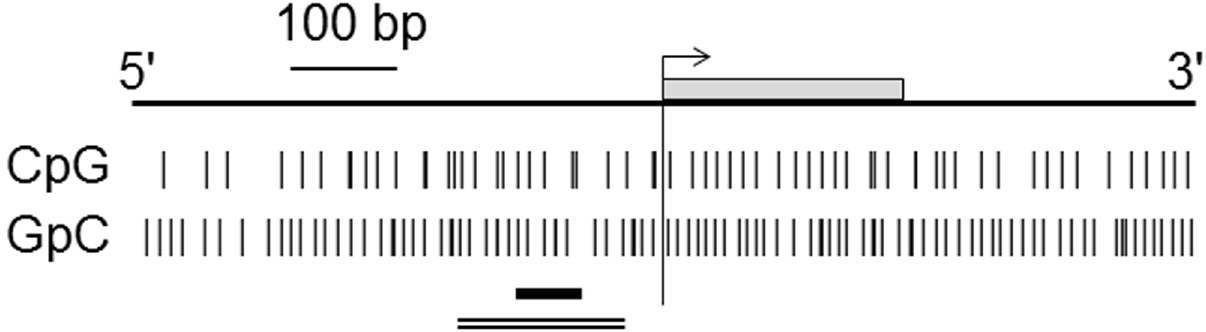
Fig 1. Structure of the 5’ region of the G0S2 gene. The gray square indicatesexon 1. The long vertical line indicatesthe transcriptional start site. The short vertical lines indicate individual CpG sites (upper)and GpC sites (lower). The analyzedregionsare shown as a single horizontal line for RT-MSP and as a doublehorizontal line for